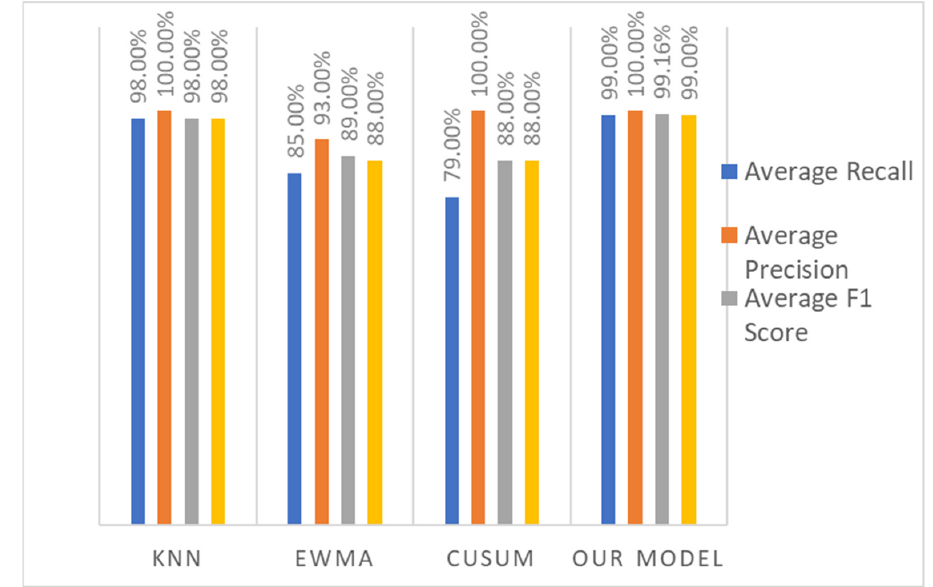
Figure 13. Average performance of EWMA, CUSUM, and KNN.